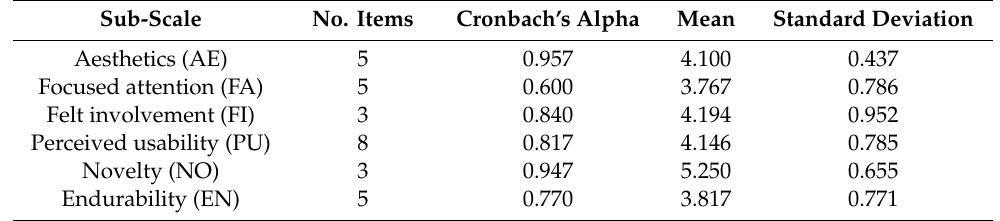
Table 1. Sub-scales, items, and sub-scale means and standard deviation of user engagement scale (UES). Sub-Scale No. Items